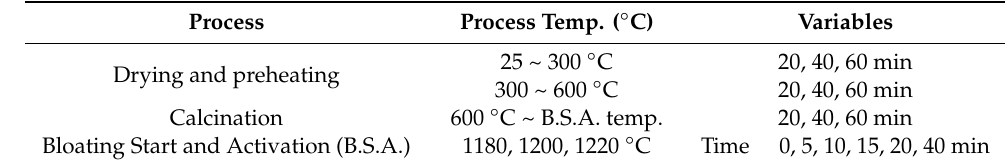
Table 1. Processing variables by